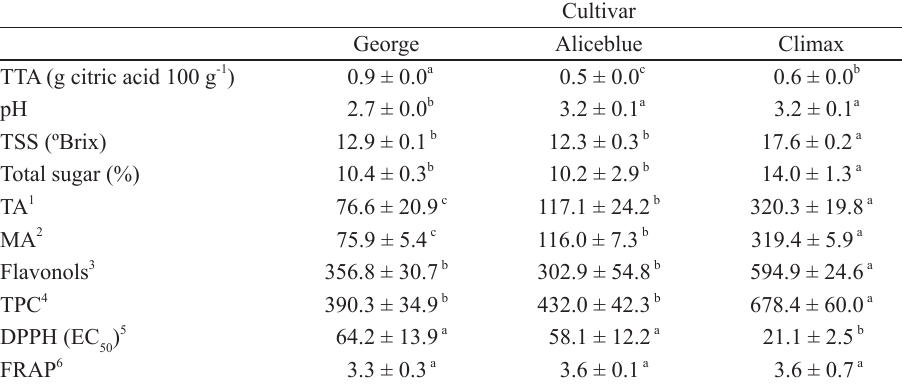
Chemical composition of selected cultivars of blueberry fruit from itaara – RS.